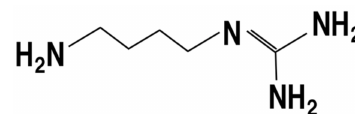
Figure 10. Chemical structure of